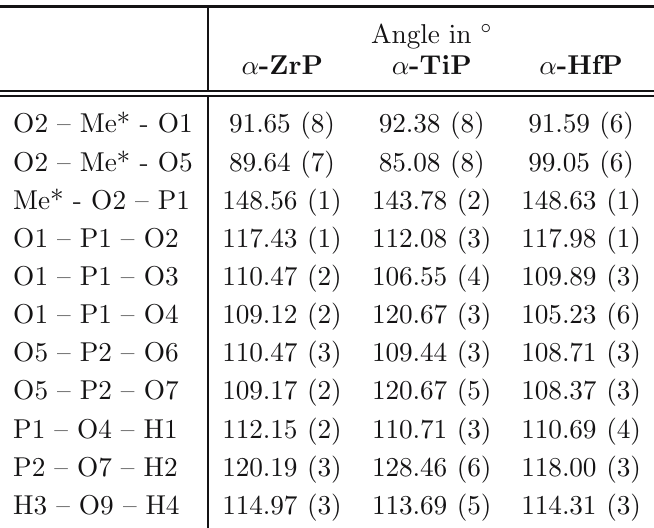
Table 7 Selected bond